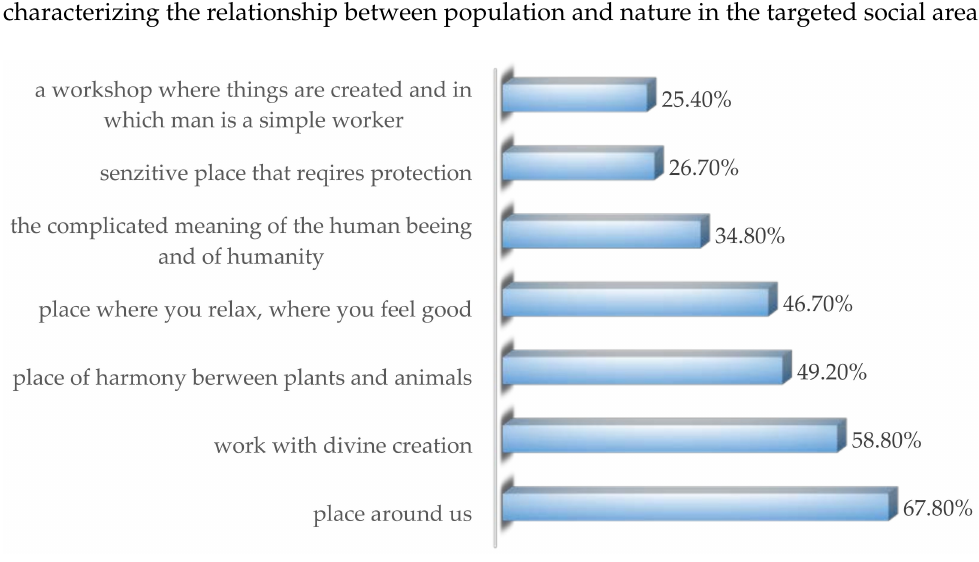
Figure 3. Social and collective representation of nature in the case of Bihor County